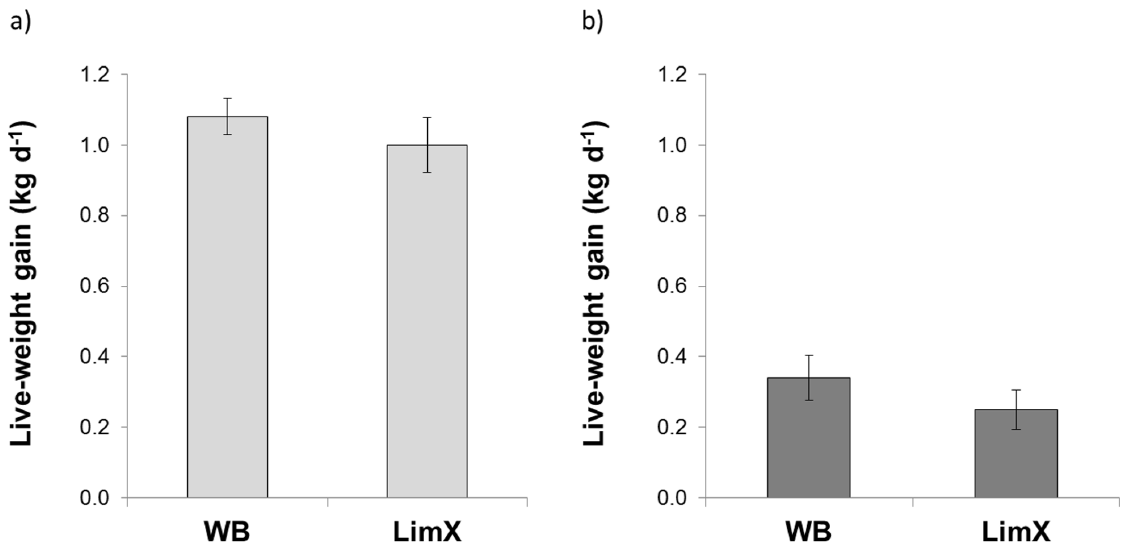
Figure 1. Effect of breed type on growth rates of steers grazing on a) lowland ryegrass, and b) semi-improved hill pasture. (Where WB=Welsh Black and LimX=Limousin cross; values plotted are mean 6 standard errors).